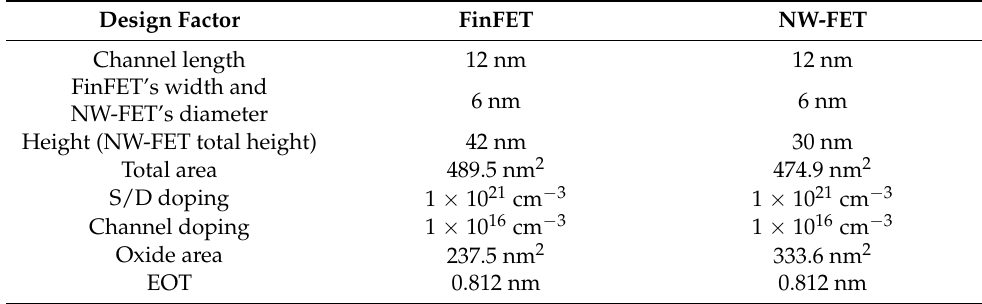
Table 1. Device’s parameters.